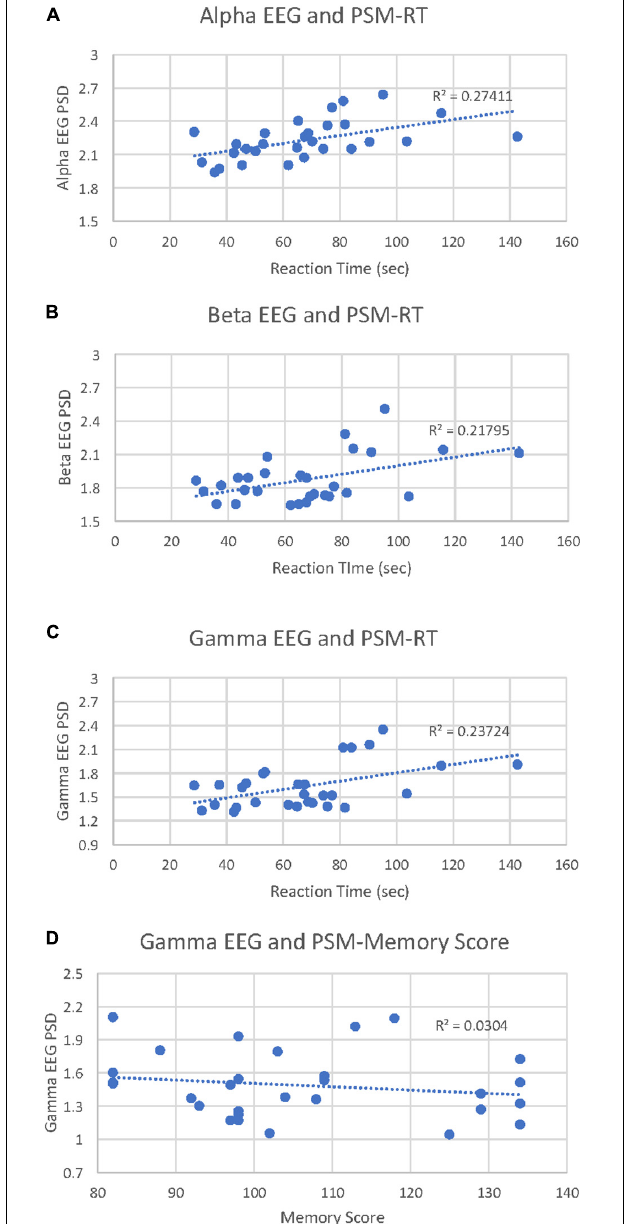
FIGURE 3 | Picture Sequence Memory (PSM)-EEG activity correlations with PSM reaction times and cognitive scores. (A) scatterplot displays all data points for the PSM-alpha EEG PSD correlation with PSM-reaction time (RT). (B) scatterplot displays all data points for the PSM-beta EEG PSD correlation with PSM-RT. (C) scatterplot displays all data points for the PSM-gamma EEG PSD correlation with PSM-RT. (D) scatterplot displays all data points for the PSM-gamma EEG PSD correlation with PSM-cognitive